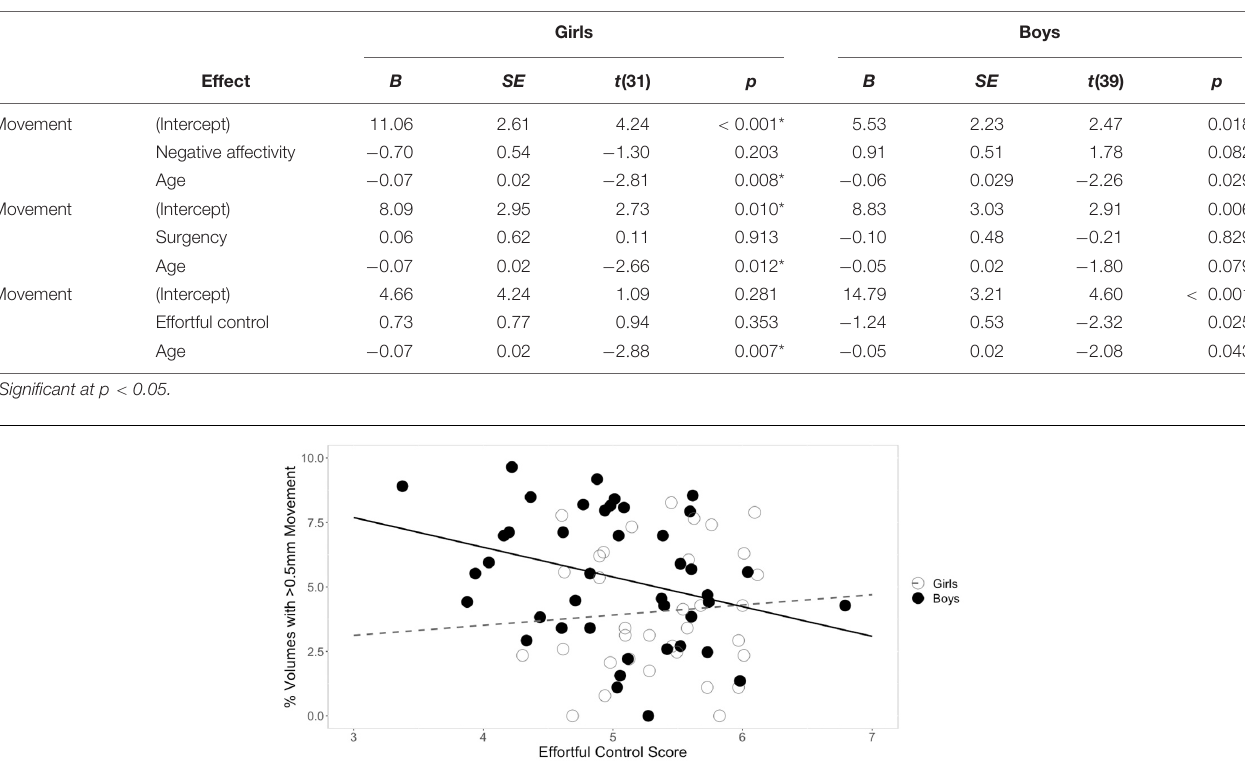
TABLE 7 | Regression results examining effects of age and temperament in boys and girls.